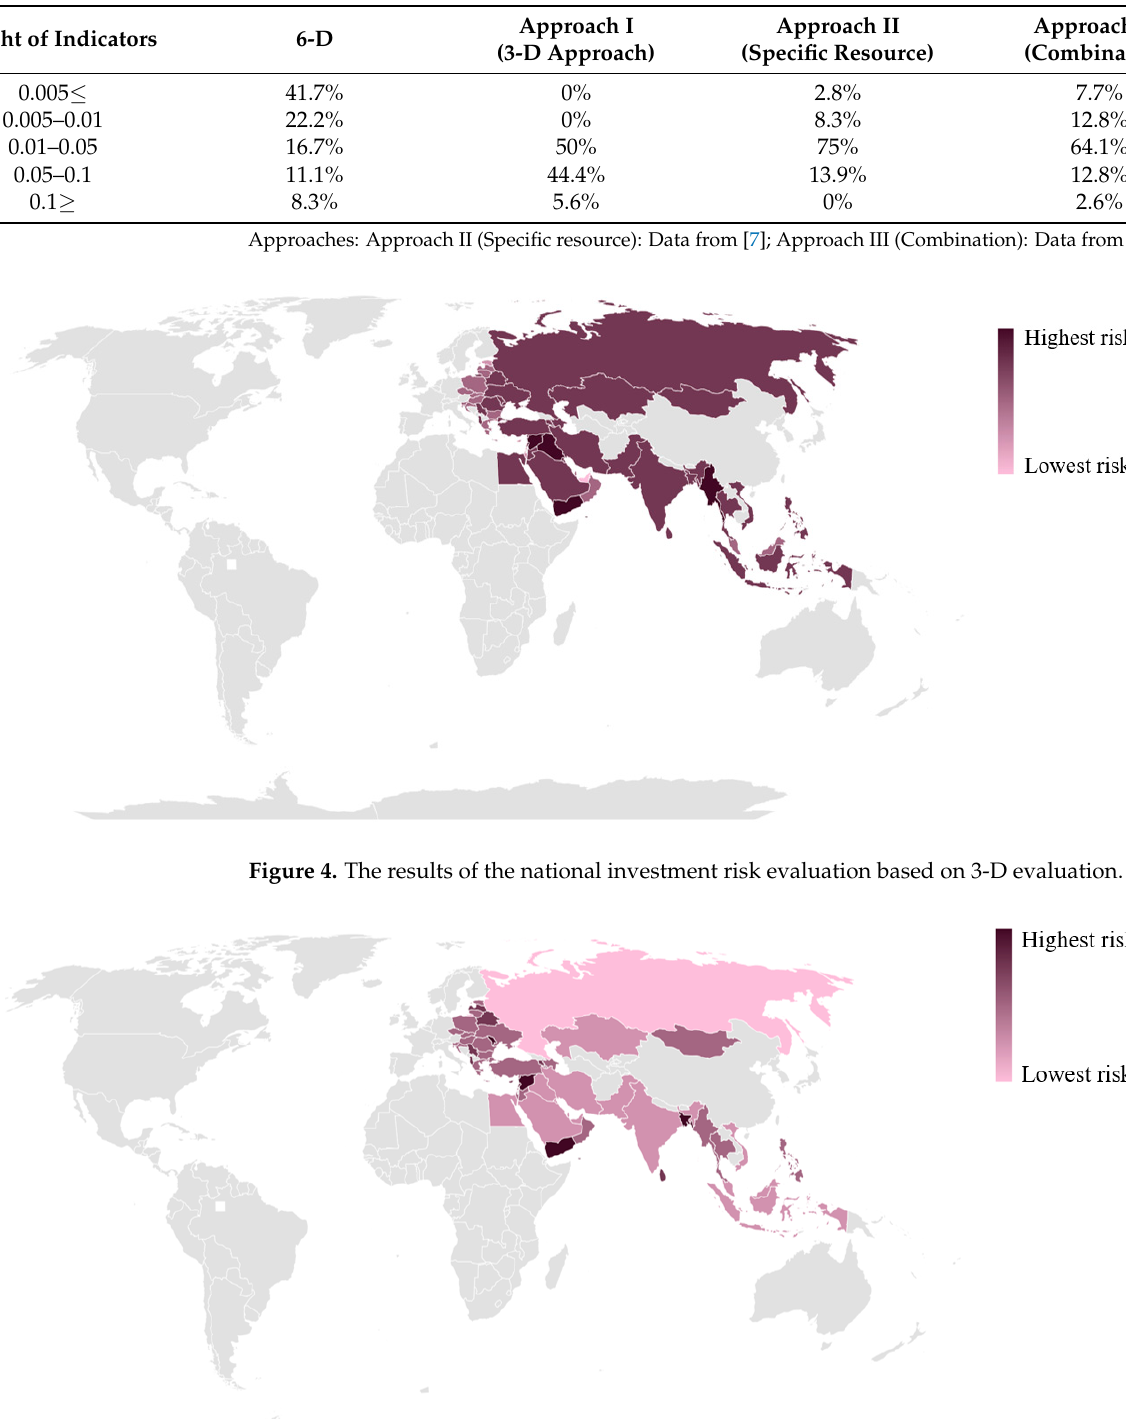
Table 5. Distribution of weights.